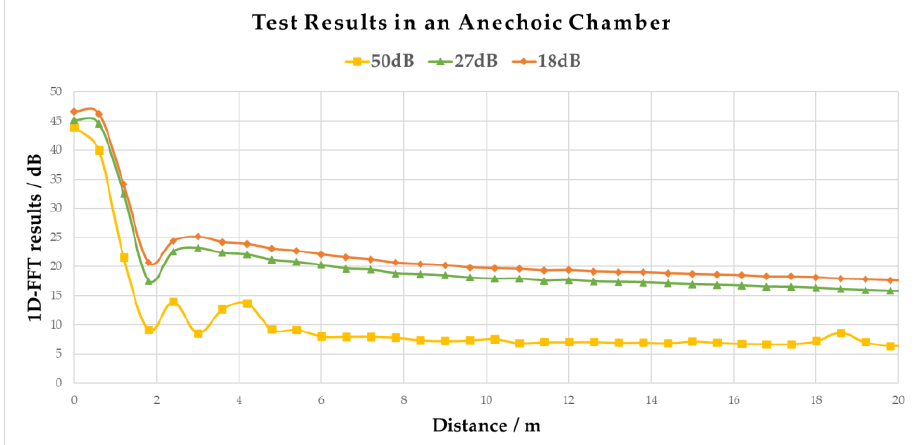
Figure 6. 1D-FFT test results in an anechoic chamber.